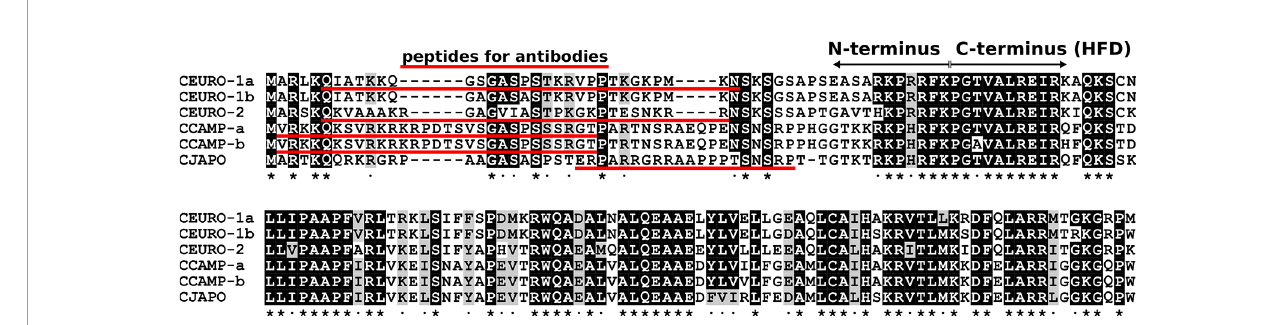
FIGURE 1 | Comparison of CENH3 protein sequences identi fi ed in C. europaea (CEURO), C. campestris (CCAMP), and C. japonica (CJAPO). The alignment of CENH3 protein sequences is shaded to highlight invariable sites (black) and sites containing similar amino acid residues (gray). These sites are also marked below the alignment by asterisks and dots, respectively. Note that the sequences are relatively conserved at their C-termini, which contain the histone fold domain (HFD), but are highly divergent at the N-terminus. Sequences of peptides used to produce CENH3-speci fi c antibodies are